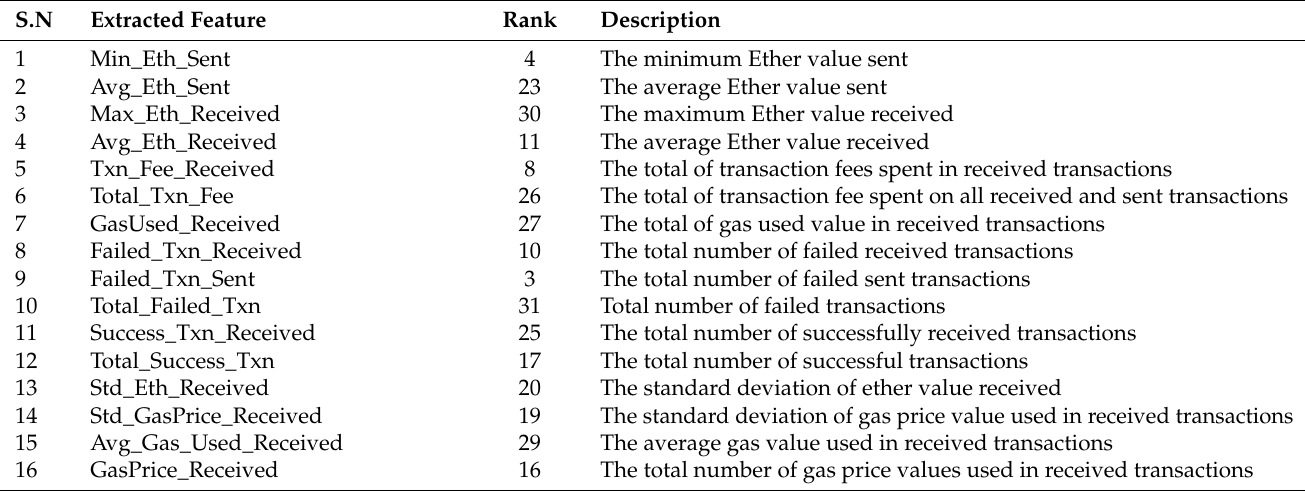
Table 4. List of transaction